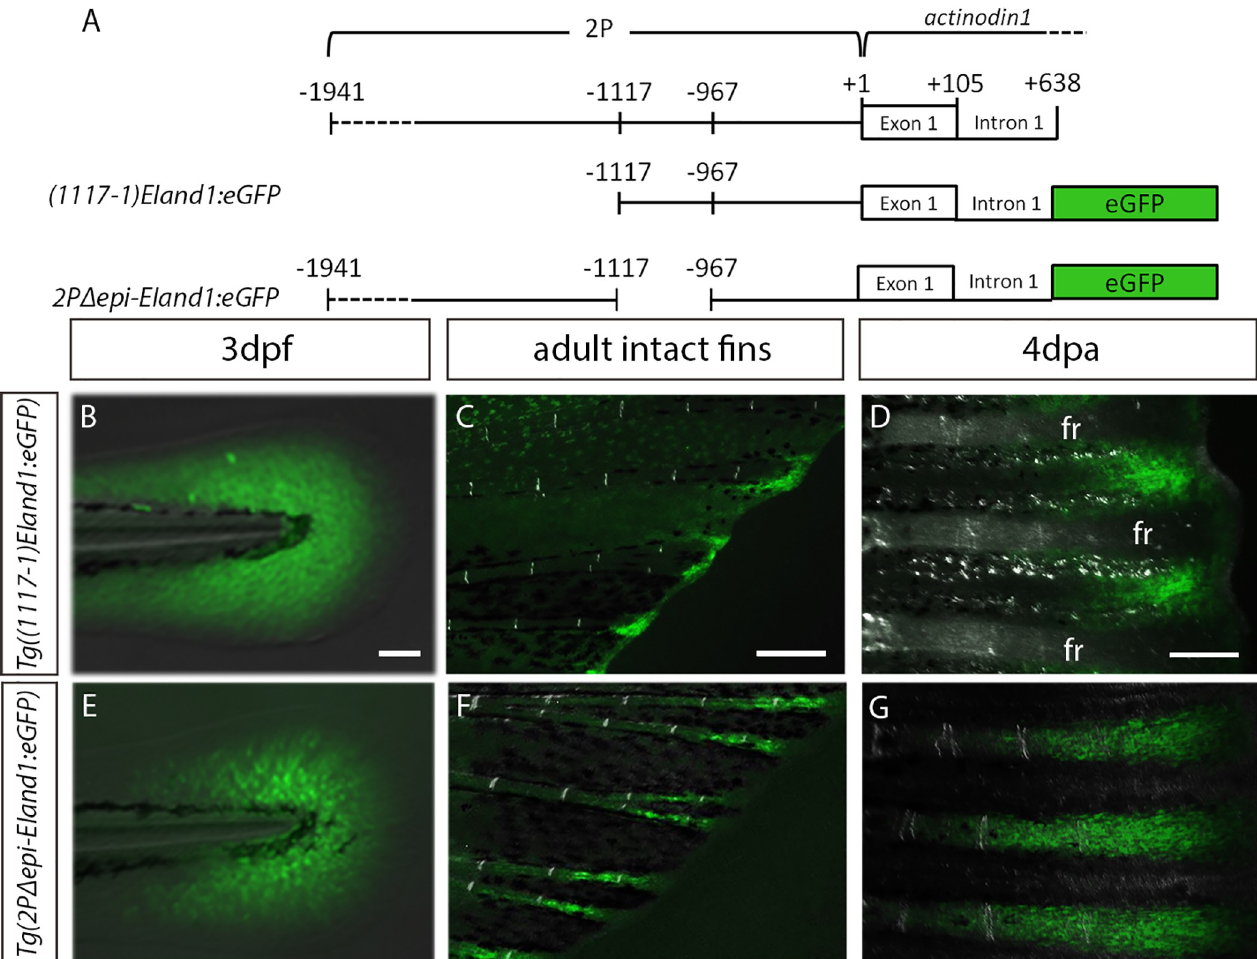
Fig 6. EI contains an adult tissuetranscriptional booster. In vivo time course analysis of reporter expression of Tg((1117–1)EIand1 : eGFP) (N = 3; n = 35) (B-D) and Tg(2P Δ epi-EIand1 : eGFP) (N = 3; n = 31) (E-G), at 3dpf (B, E), in intact fins at 90dpf (C, F), and at 4dpa (D, G) during fin regeneration. Note: adult fins are oriented in the proximal to distal direction (left to right). (B-D) Tg((1117–1)EIand1 : eGFP ) expression only occurs in the ectodermal/basal epithelial tissue; (E-G) Tg(2P Δ epi-EIand1 : eGFP) , only mesenchymal tissue. fr: fin ray. N = number of lines found; n = total number of fish analysed. Scale bars: B, E = 25 μ m, C, F = 200 μ m and D, G = 200 μ